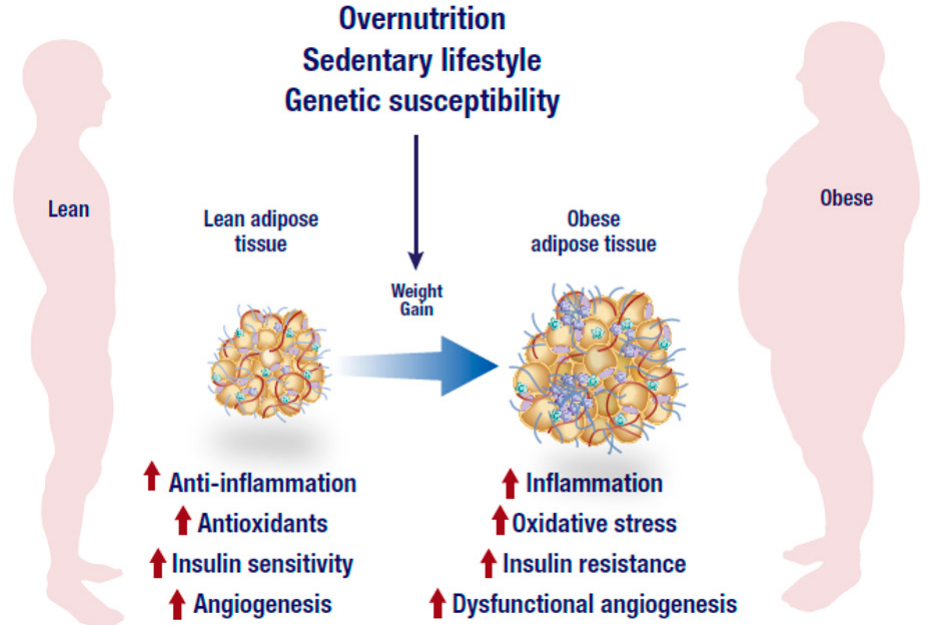
Figure 1. Overnutrition, sedentary lifestyle and genetic susceptibility are the leading factors associated with the development of obesity. In addition to dysfunctional angiogenesis, an obese state is characterized by an abnormal inflammatory response, low antioxidant capacity and reduced insulin sensitivity that may eventually lead to the generation of inflammation, oxidative stress and insulin resistance. The figure was modified from the following website, https://mexicobariatriccenter.com/improve-adipose-tissue-function/.